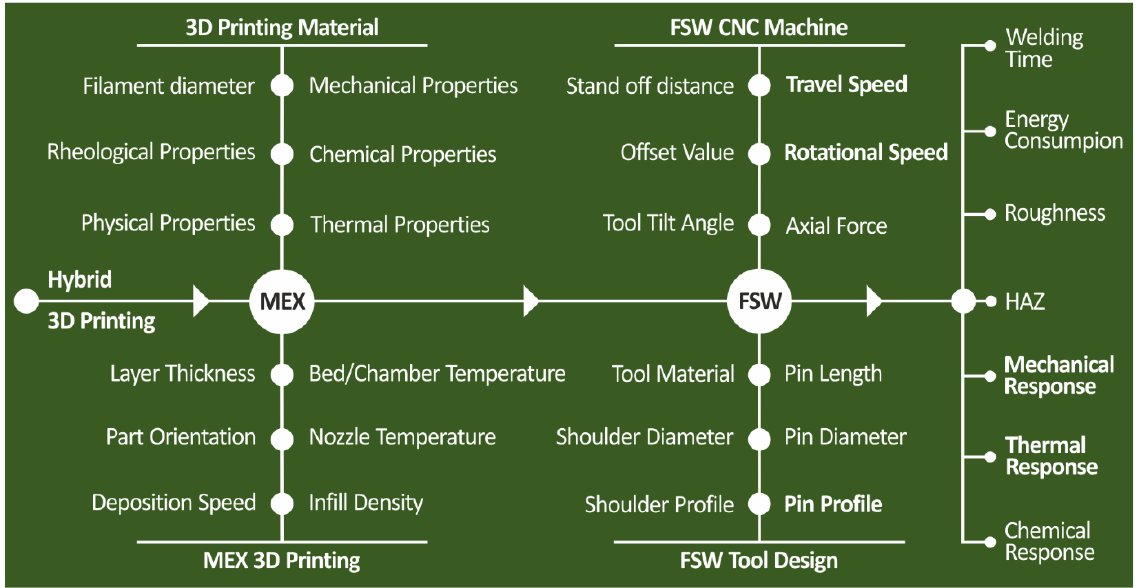
Figure 1. MEX 3D printing and FSW process parameters and the welding performance features.